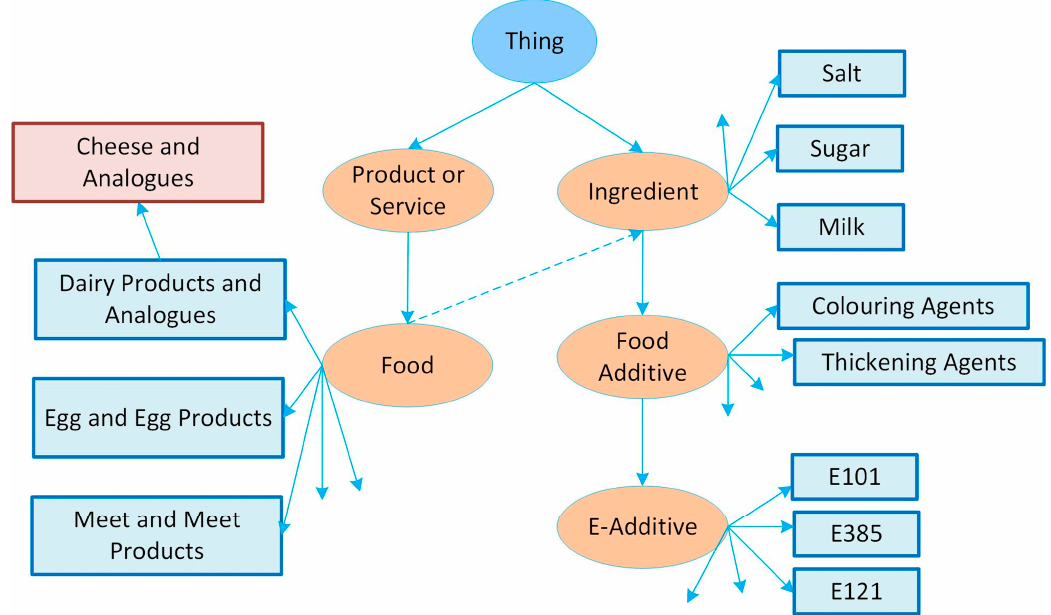
Figure 3. An example of the Food Ontology Classes, modified from